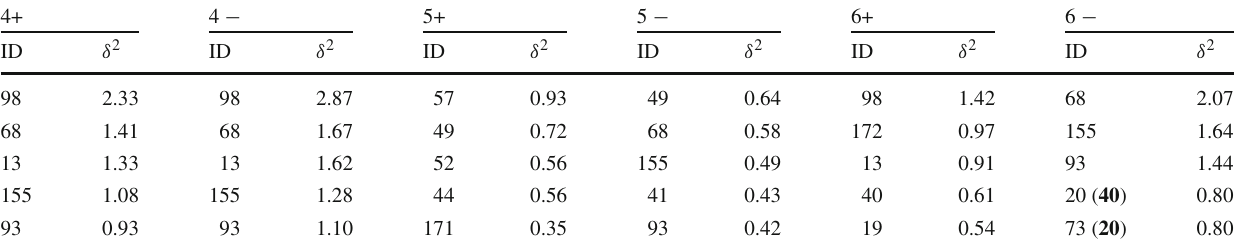
Table 5 Ranking of observables by δ along directions 4, 5, 6. In bold the changes when the SVD points are defined by the exact 1 σ surface